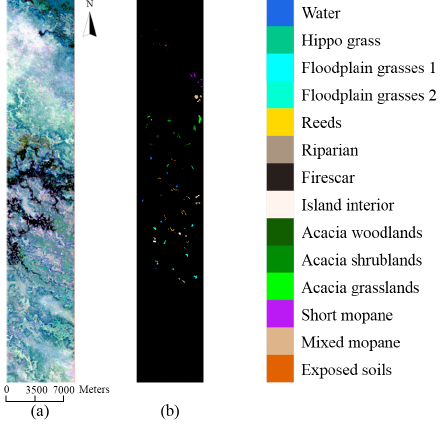
Figure 5. ( a ) False-color composite. ( b ) Ground truth; black area denotes unlabeled pixels.